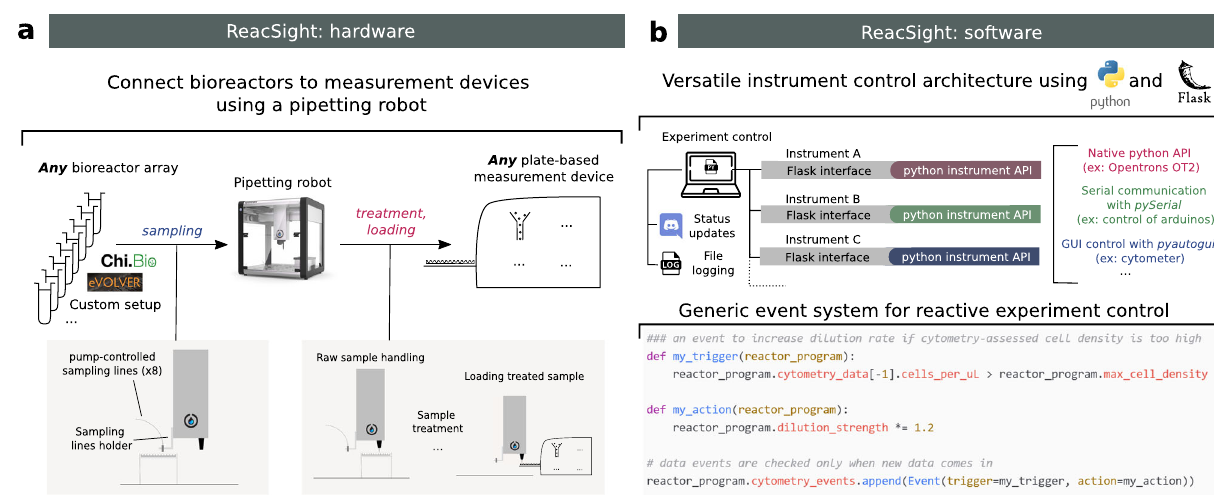
Fig. 1 ReacSight: a strategy to enhance bioreactor arrays for automated measurements and reactive experiment control. a On the hardware side, ReacSight leverages a pipetting robot (such as the low-cost, open-source Opentrons OT-2) to create a physical link between any multi-bioreactor setup (eVOLVER, Chi.Bio, custom … ) and the input of any plate-based measurement device (plate reader, cytometer, high throughput microscope, pH-meter … ). If necessary, the pipetting robot can be used to perform a treatment on bioreactor samples (dilution, fi xation, extraction, puri fi cation … ) before loading into the measurement device. If reactive experiment control is not needed, treated samples can also be stored on the robot deck for of fl ine measurements (the OT-2 temperature module can help the conservation of temperature-sensitive samples). b On the software side, ReacSight enables full platform integration via a versatile instrument control architecture based on Python and the Python web application framework Flask. ReacSight software also provides a generic event system to enable reactive experiment control. Example code for a simple use case of reactive experiment control is shown. Experiment control can also inform remote users about the status of the experiment using Discord webhooks and generates an exhaustive log fi